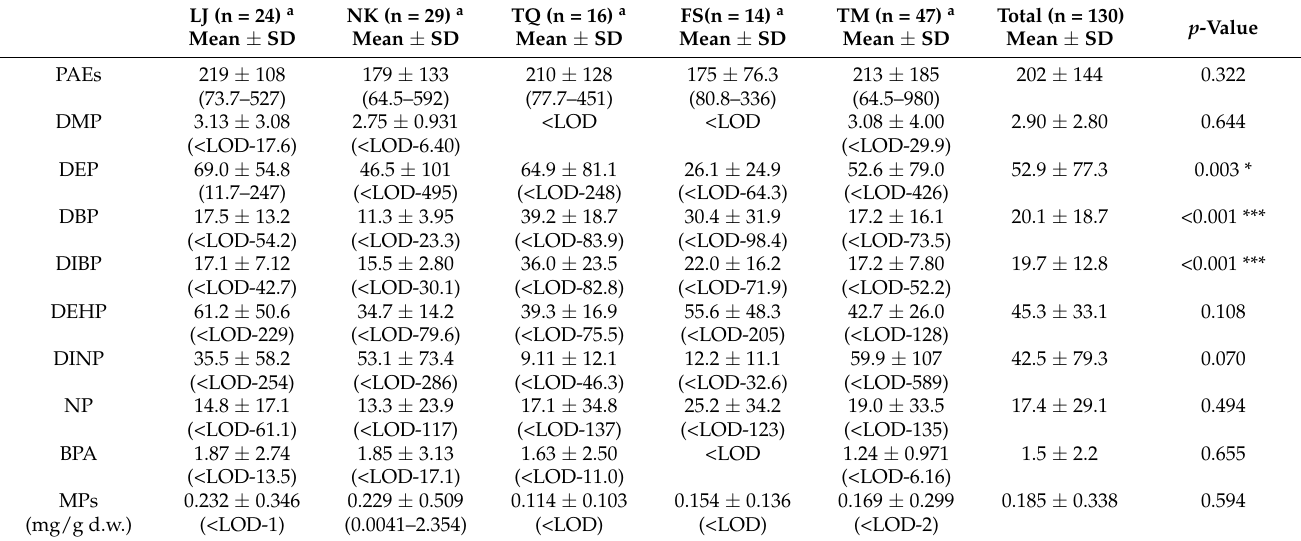
a LJ: Lao-Jie Estuary; NK: Nankan Estuary; TQ: Touqian Estuary; FS: Fengshan Estuary; TM: Tamsui Estuary. * p -value < 0.05, *** p -value < 0.001. According to the fish habitat, benthic, pelagic, and migratory fish were determined (Table 2). Benthic (46.5 and 37.5 ng/g d.w., p = 0.133 vs. p = 0.003) and pelagic (61.7 and 39.6 ng/g d.w., p = 0.041 vs. p = 0.067) fish had elevated DEP and DINP levels compared with migratory fish (22.5 and 3.58 ng/g d.w.), but benthic fish (39.0 ng/g d.w.) had the lower DEHP level than pelagic (65.0 ng/g d.w., p = 0.012) and migratory fish (72.8 ng/g d.w., p = 0.001). The other EEDCs in fish did not show significant differences in DMP, DBP, DIBP, BPA, NP, and MPs among the three fish habitat areas. Concentrations of EEDCs and MPs among three groups of fish habitat in each river estuary are presented in Figure 2A–E).